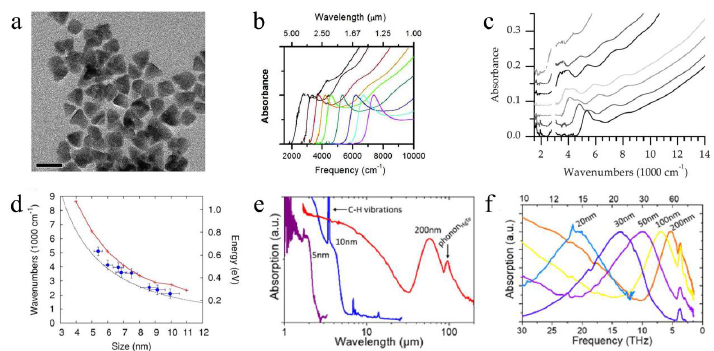
Figure 2. ( a ) Transmission electron microscopy image of HgTe CQOs, scale bar is 20 nm, adapted with permission from [35]; Copyright 2011 American Chemical Society. ( b ) The spectral absorption of HgTe CQDs with cut-off wavelength up to 5 µm, adapted with permission from [35]; Copyright 2011 American Chemical Society. ( c ) Absorption spectra of particles of different sizes show better spectral resolution, adapted with permission from [43]; Copyright 2014 American Chemical Society. ( d ) Blue dots: A functional relationship between the photoluminescence peak energy and the CQDs size measured in TEM images. Red line and crosses: calculation of exciton gap of truncated tetrahedral shape CQDs. Black dotted line: calculation of exciton gap versus diameter of spherical CQDs. Adapted with permission from [43]; Copyright 2014 American Chemical Society. ( e ) Absorption spectra of various sizes HgTe CQD, adapted with permission from [45]; Copyright 2018 American Chemical Society. ( f ) Absorption spectra of various sizes HgTe CQDs, presenting an intraband/plasmonic characteristic in the LWIR, very long-wavelength infrared range (VLWIR, 12−20 μm range) or THz range, adapted with permission from [45]; Copyright 2018 American Chemical Society.